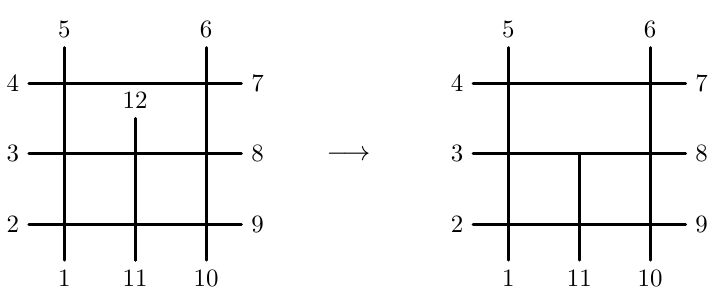
Figure 2 . Replacing one external leg of a non-planar 12-point diagram by a VEV turns it into a planar 11-point